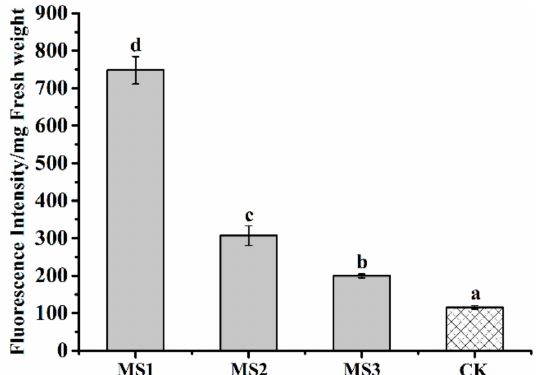
Figure 15. Effects of the azoxystrobin microspheres on intracellular ROS in Colletotrichum higginsianum Sacc. For fluorescent values, different lowercase letters indicated statistically significant differences (one-way ANOVA, SNK test, p < 0.05).